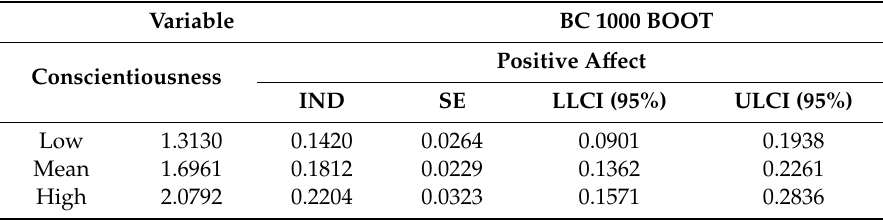
Table 6. Indirect e ff ects of discrimination on positive a ff ect, by level of